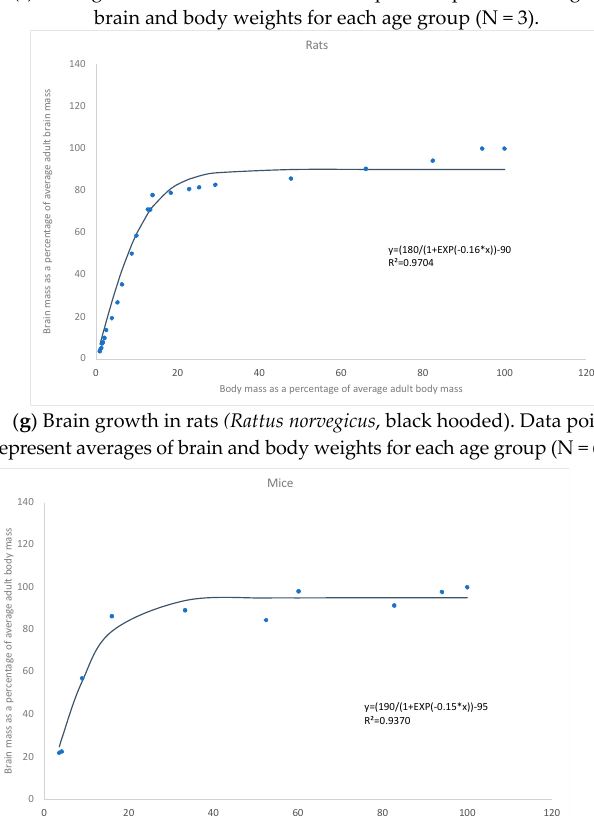
BRAIN = 25 + 14 ln (BODY)